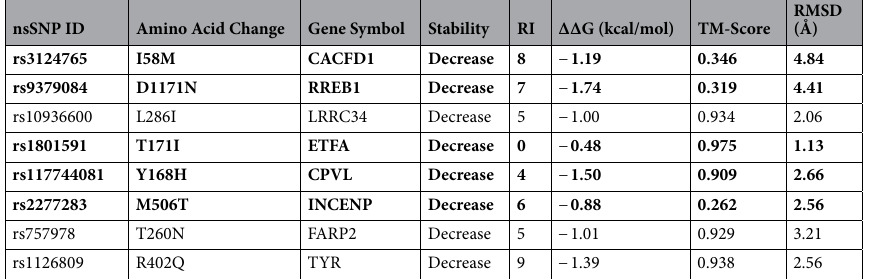
RMSD values shown in Table 5. The nsSNP models of I58M, D1171N, and M506T have very low TM-score values of 0.346, 0.319, and 0.262, respectively, which correspond to randomly chosen unrelated proteins 49 . Hence, we